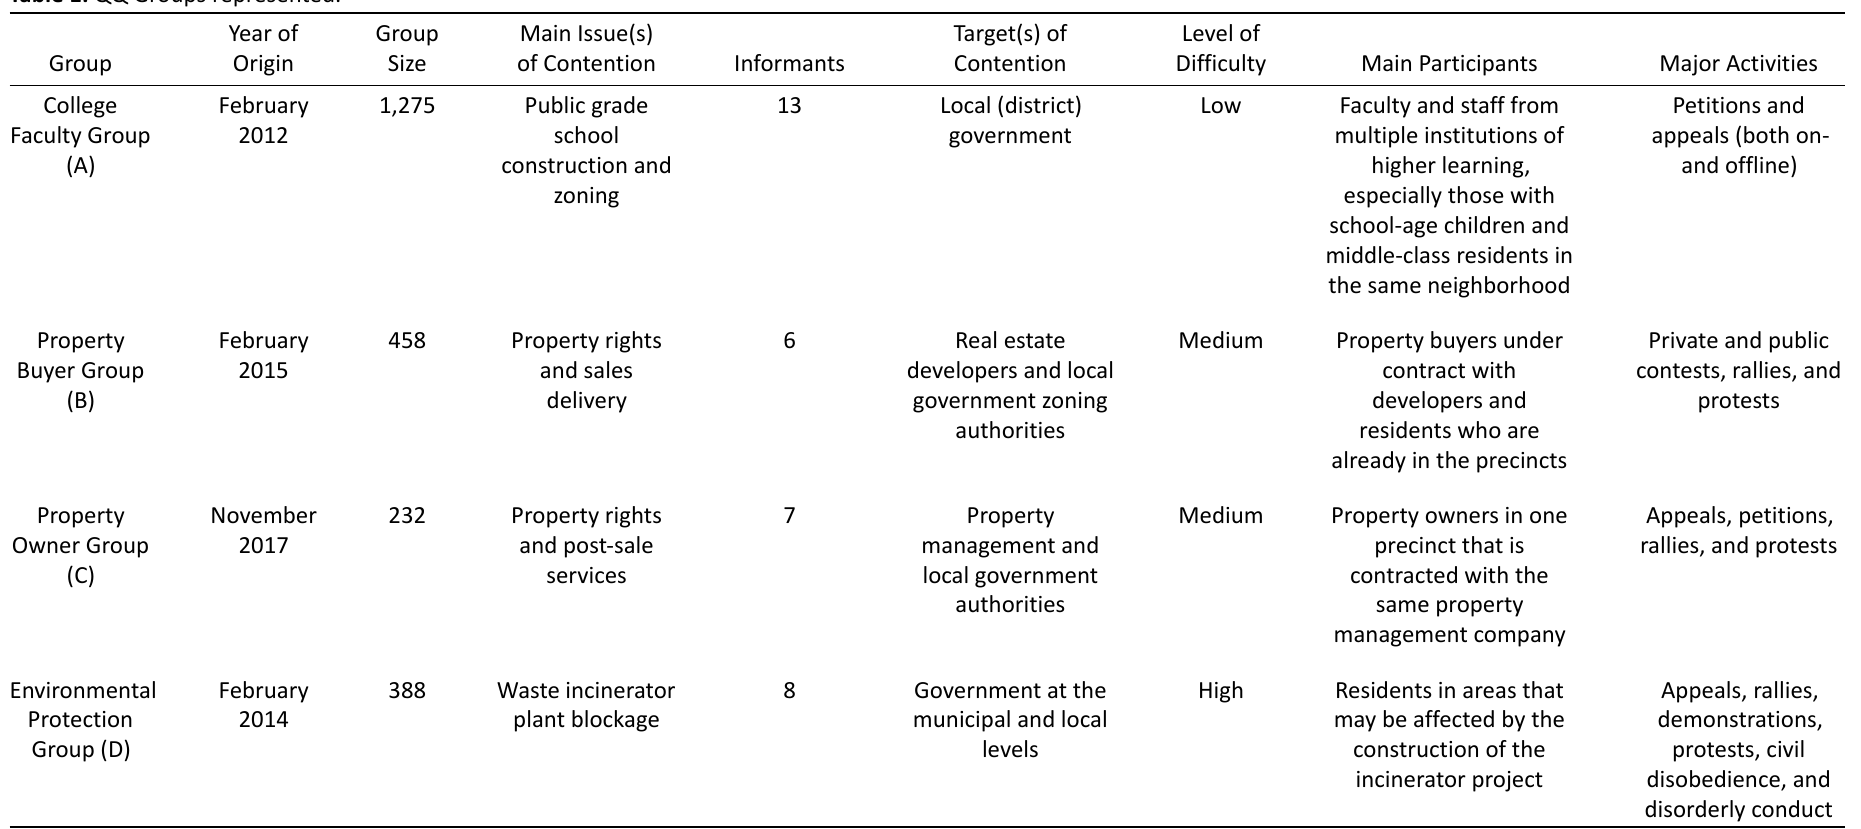
Table 1. QQ Groups